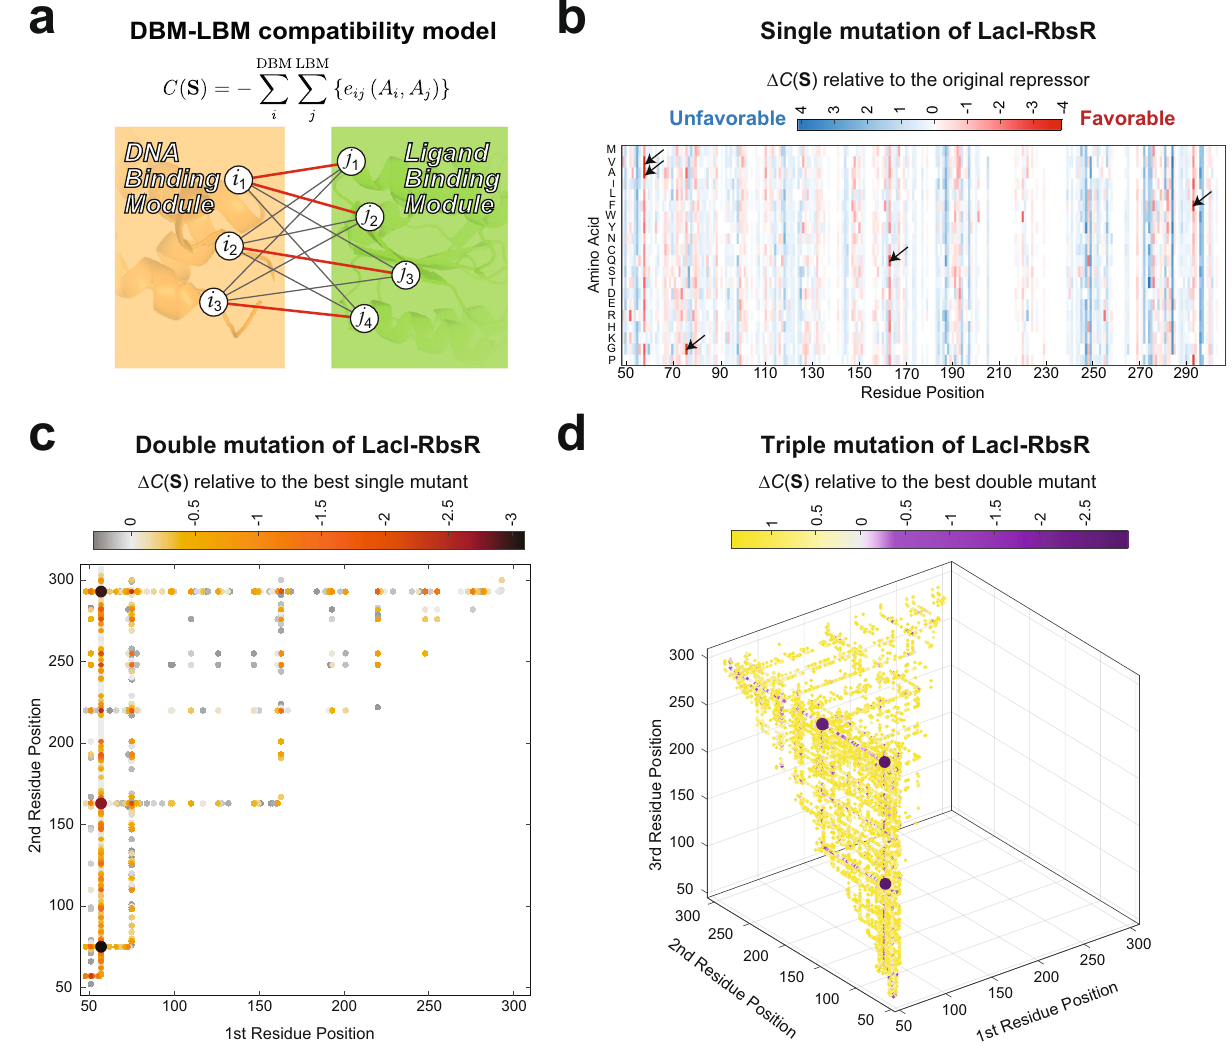
Fig. 1 A computational approach to modulate hybrid repressors. a We identify a set of DNA-binding modules (DBMs) and ligand-binding modules (LBMs) interactions based on coevolutionary cues among LacI family members. These interacting residue pairs were used to develop a computational model for computing a compatibility score C ( S ) that re fl ects compatibility between a DBM and an LBM. b We then applied this model to improve the repressor activities of a hybrid repressor, LacI-RbsR. The heatmap shows the Δ C ( S ) scores of all LacI-RbsR candidates with a single mutation at its LBM relative to the score for original repressor ( C ( S ) score: − 62.10). Similarly, we calculated the C ( S ) scores of ( c ) double mutants and ( d ) triple mutants and plotted the Δ C ( S ) scores relative to the best single mutant and best double mutant,